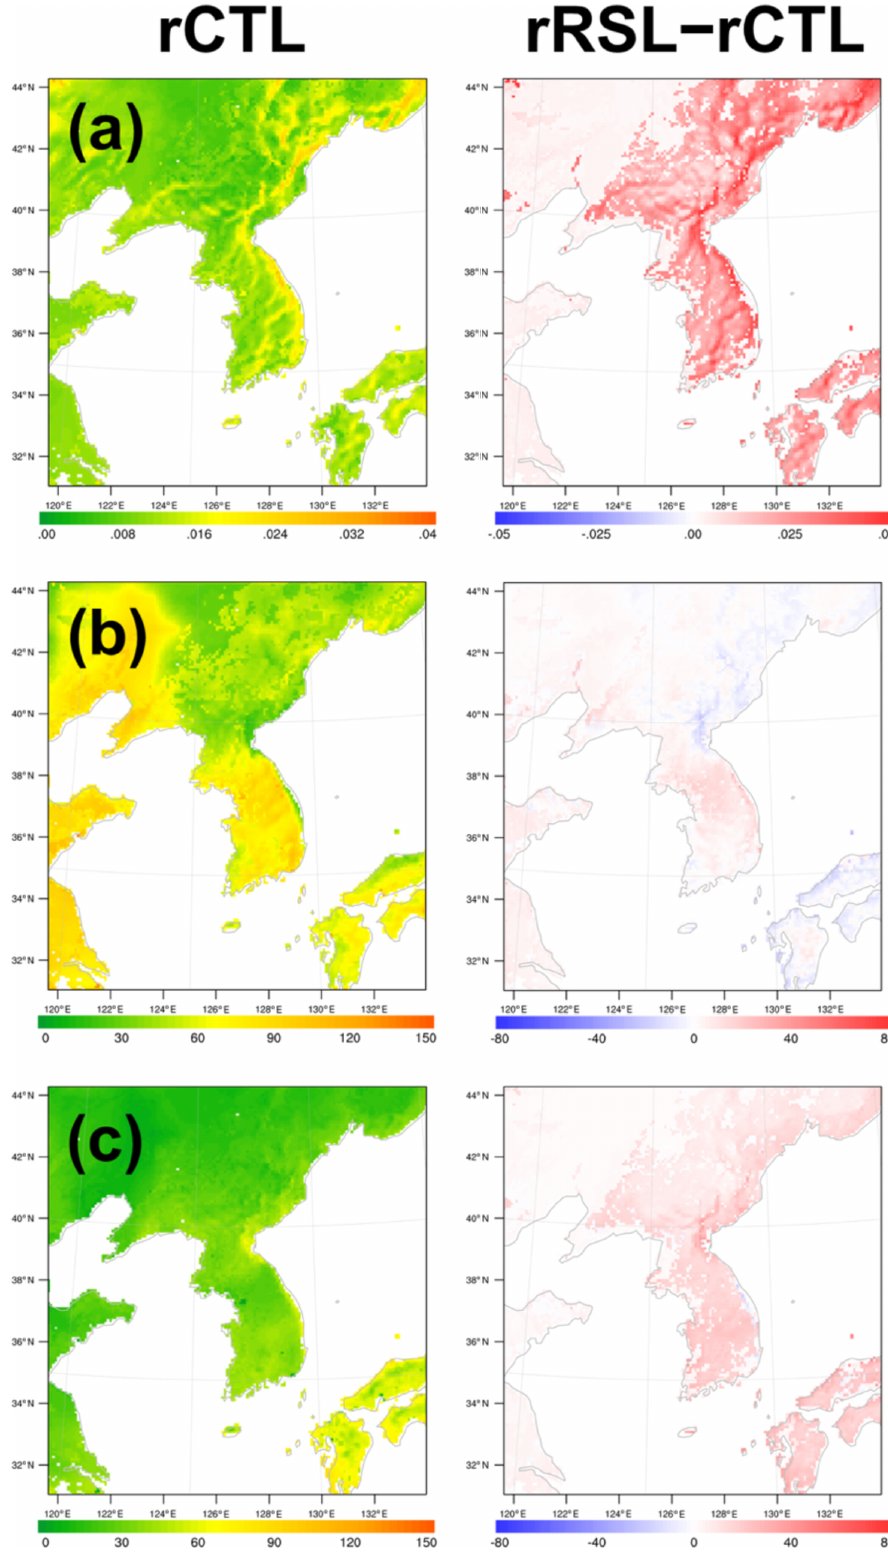
Figure 11. (a) Aerodynamic conductance (ms − 1 ), (b) daytime sensible heat flux (Wm − 2 ), and (c) daytime latent heat flux (Wm − 2 ) of the (left) rCTL experiment and (right) the difference (rRSL–rCTL). The results are averaged over a period of 1 month and masked out over the